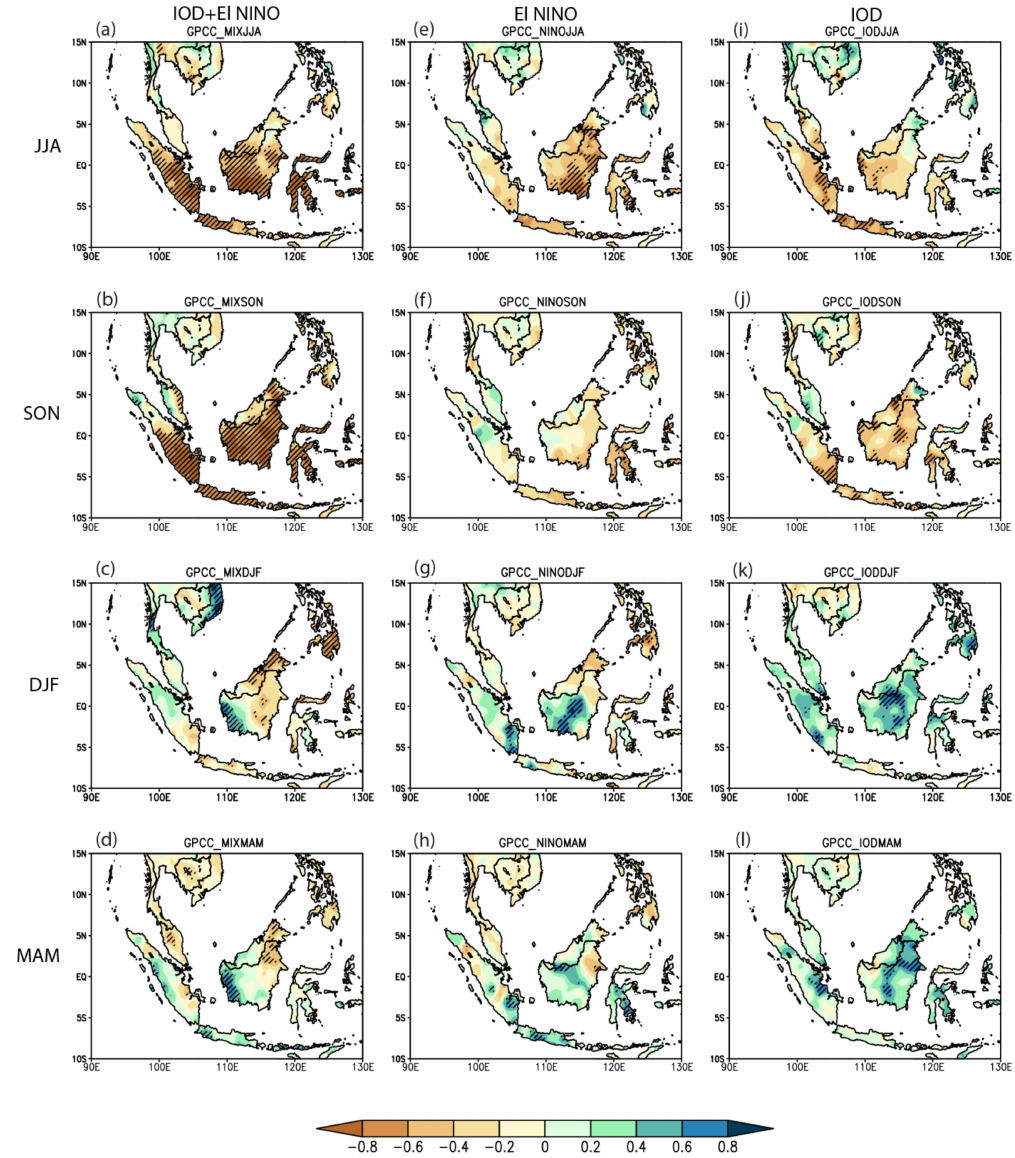
Figure 1. The composite of anomalous rainfall for the events listed in Table 1. The hatched area indicates significance at the 95% level. ( a – d ) Co-occurrence of the conventional El Niño and positive IOD, ( e – h ) pure conventional El Niño, and ( i – l ) pure positive IOD for the season of June-July-August (JJA), September-October-November (SON), December-January-February (DJF), and March-April-May (MAM). Unit is mm month − 1